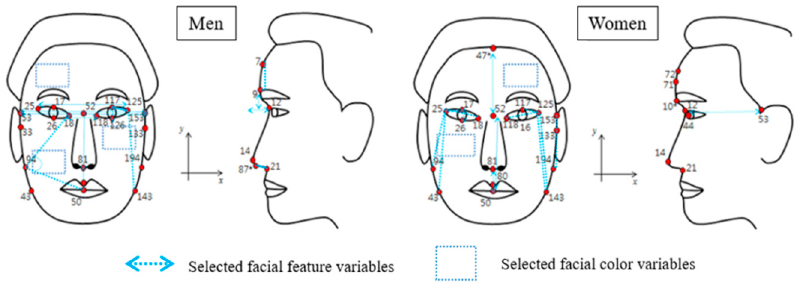
Figure 3. Illustration of selected variables by LASSO for both genders.